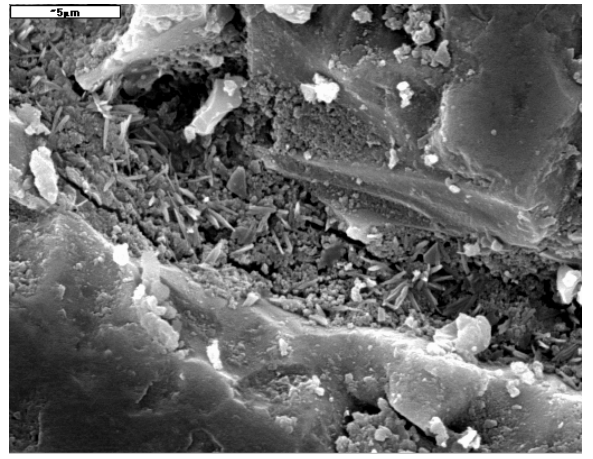
Fig 8. SEM image of silicate gel filling a crack in granite grain